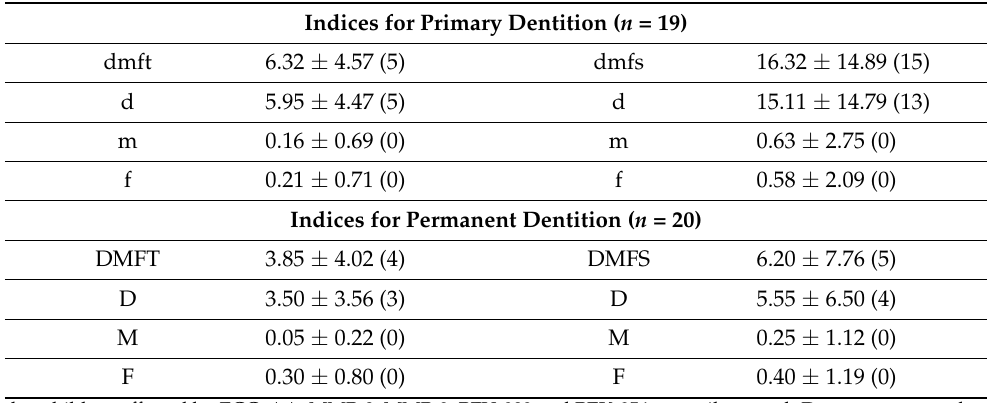
Table 1. Carious Experience in the Study